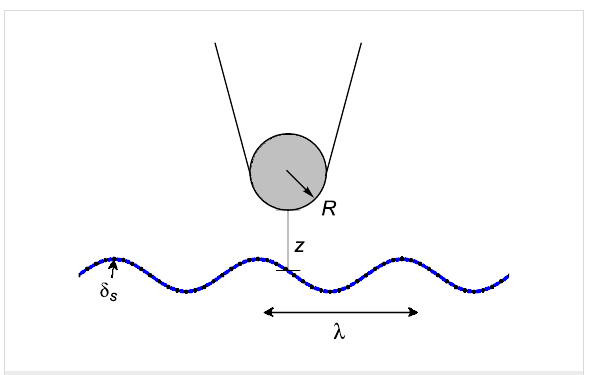
Figure 3: Schematic illustrating the model geometry: The surface is sinusoidally corrugated along the x direction only, with wavelength λ and amplitude δ s . The surface corrugation is independent of y (quasi- 1-D geometry). The tip is modeled as a sphere of radius R .